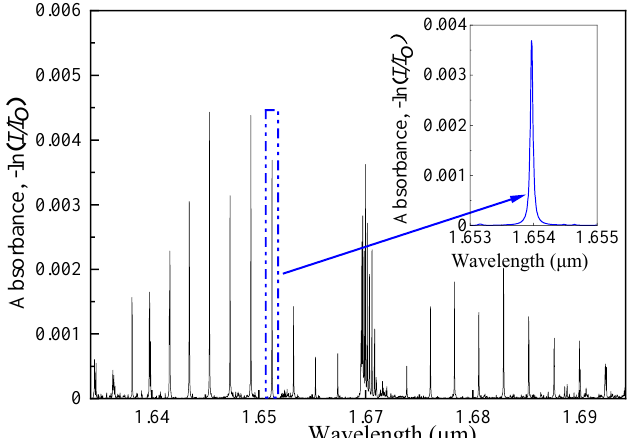
Figure 1. Selected CH 4 absorption line at 1654 nm in the near-infrared region.